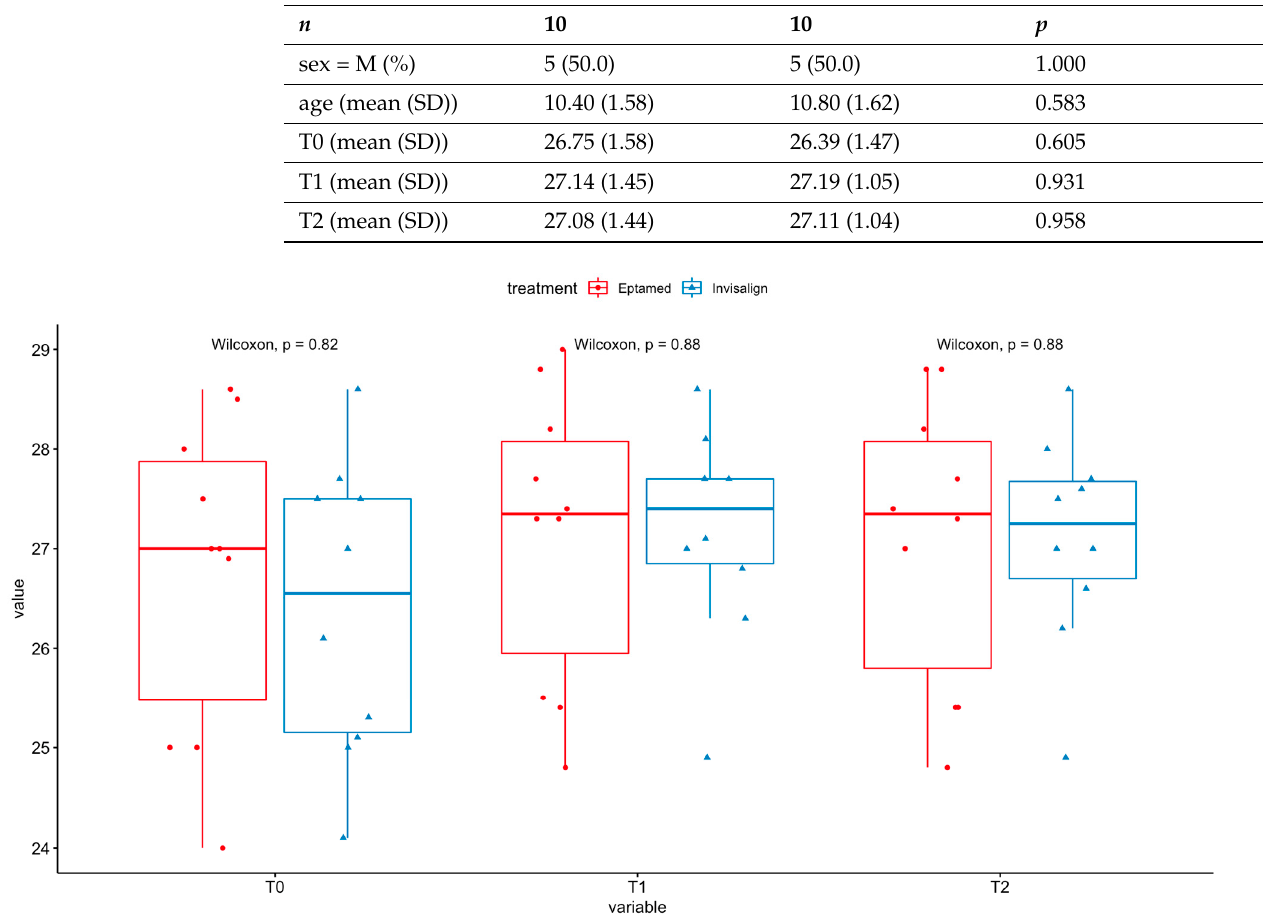
Table 1. Results (mean and SD) for the two groups. Distances between the lower canines at T0, T1, T2 are expressed in mm. There is no statistically significant difference in the values of the two groups related to sex or age at T1 and T2. Stratified by Treatment Eptamed Invisalign